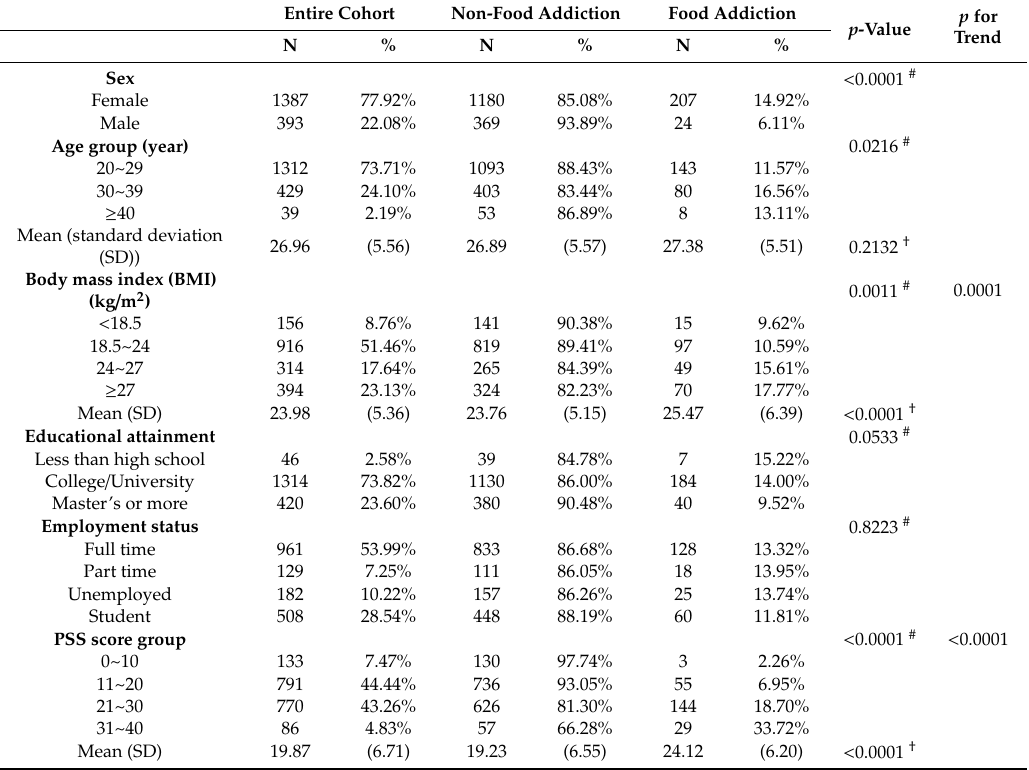
Table 1. Participant characteristics and distributions of those with and those without a food addiction (FA) by sociodemographic